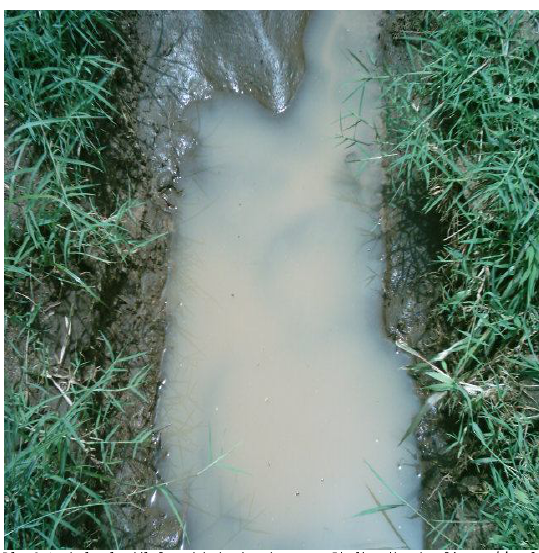
Plate 1. Turbid shoreline puddle with floating aquatic vegetation: